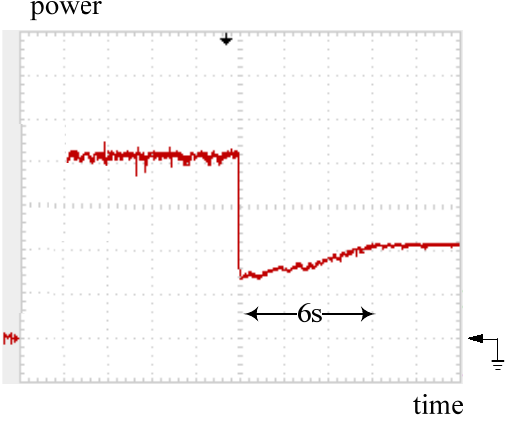
Figure 24. Practical measurement: tracking trajectory of the converter with the POM while PV power steps down from 200 to 100 W. Note: power: 50 W/div; time: 2 s/div.